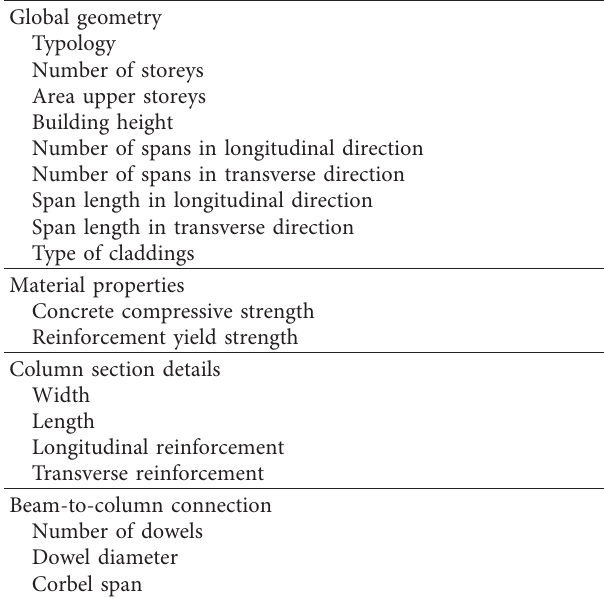
Table 1: List of properties collected for each RC precast